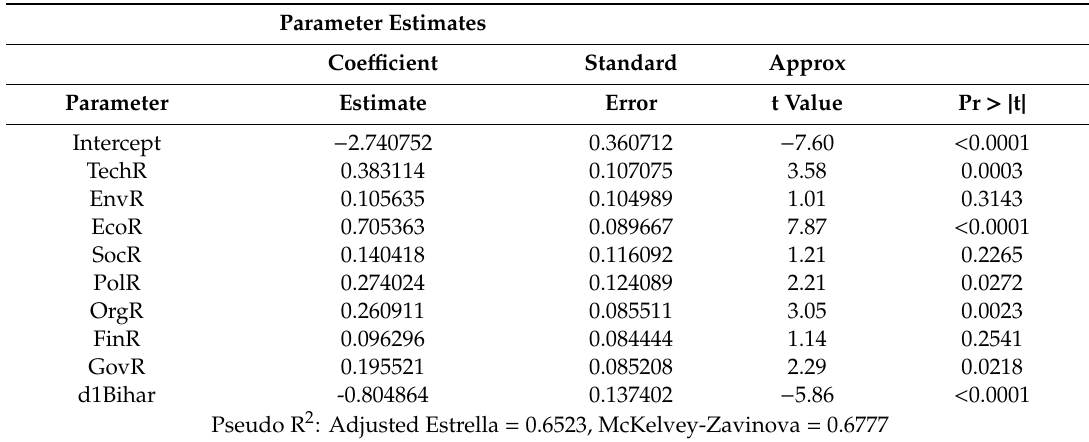
Table 12. Ordered probit regression results—rationalities and production / economic performance.